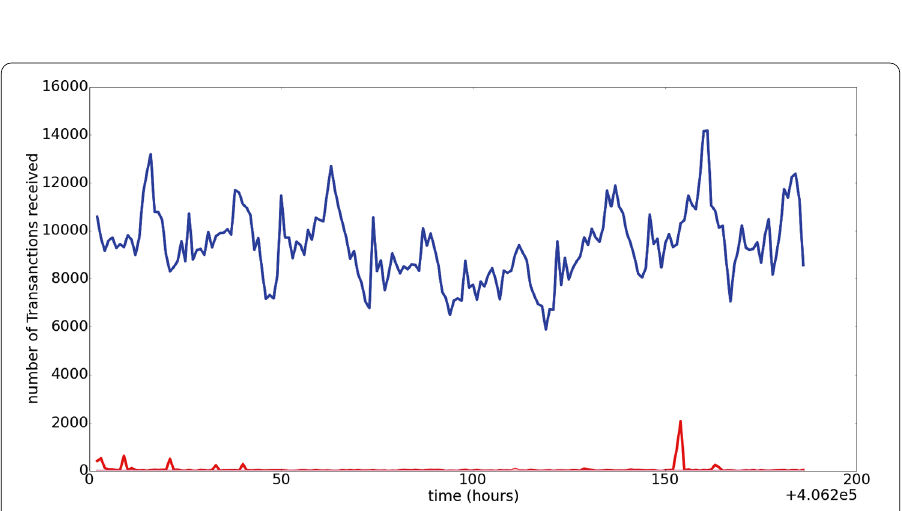
Figure 3 Unique Transaction per hour. Number of Transactions per hour received during the listening time. The blue line represent the transactions included in the Blockchain during or after the listening time (BT). The red line represent the invalid transactions